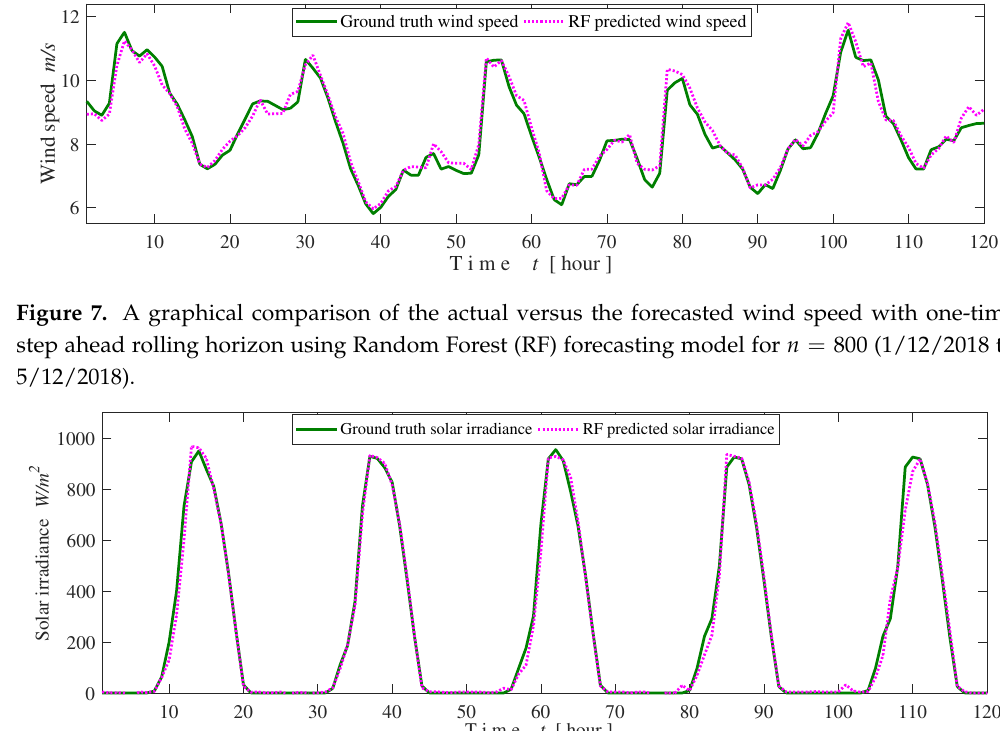
Figure 8. A graphical comparison of the actual versus the forecasted solar irradiances with one-time step ahead rolling horizon using RF forecasting model for n = 80 (1/12/2018 to